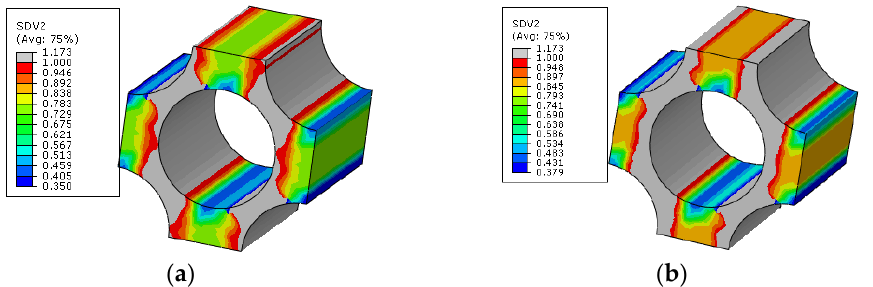
Figure 23. Matrix damage propagation in the matrix for fiber diamond distribution model. ( a ) at